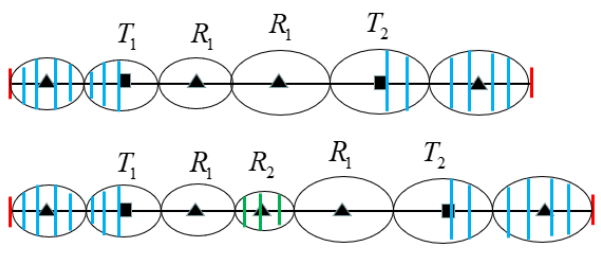
Figure 19. When a receiver is inserted into sequence T 1 − R n − T 2 .